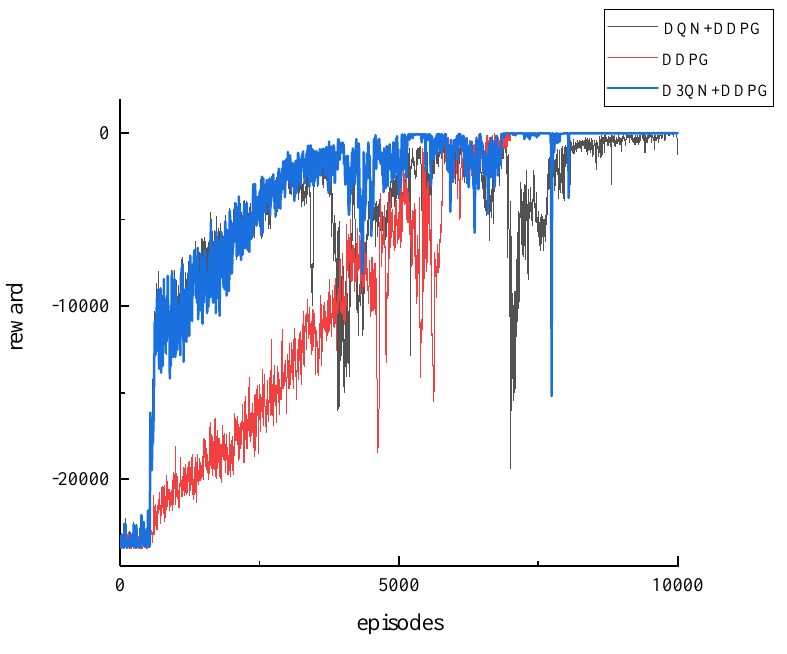
Figure 6. HDRL training